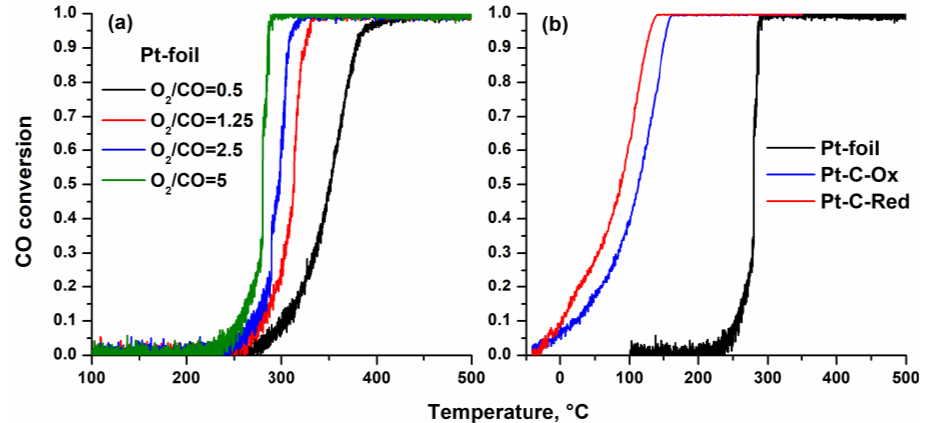
Figure 3. Temperature dependencies of CO conversion for ( a ) Pt foil at O 2 /CO = 0.5, 1.25, 2.5 and 5 and ( b ) Pt foil and Pt-C at O 2 /CO = 5. Ox, pretreatment in oxidative (1.0 vol.% O 2 /He), and Red, pretreatment in reductive (1.0 vol.% H 2 /He) atmospheres at 350 °C for 2 h. The reaction mixture contains 0.2 vol.% CO, 0.1 – 1 vol.% O 2 , and 0.5 vol.% Ne and He balance. The reaction mixture rate was 1000 cm 3 /min, which corresponded to the space velocity (SV) 600 and 300 L/g · h for the Pt-C catalyst and the Pt foil, respectively. The heating rate was 10 ◦